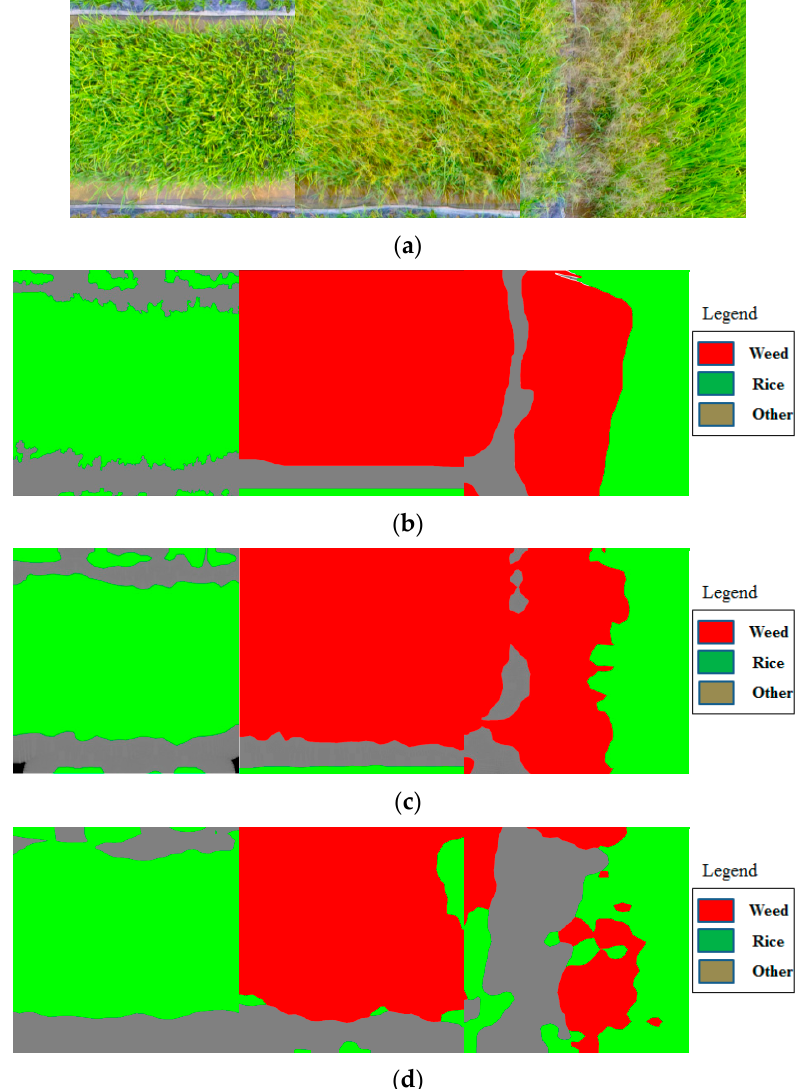
Figure 9. ( a ) UAV imagery, ( b ) corresponding labels, ( c ) results obtained by FCN-AlexNet, and ( d ) results obtained by FCN-AlexNet optimized with precision calibration.